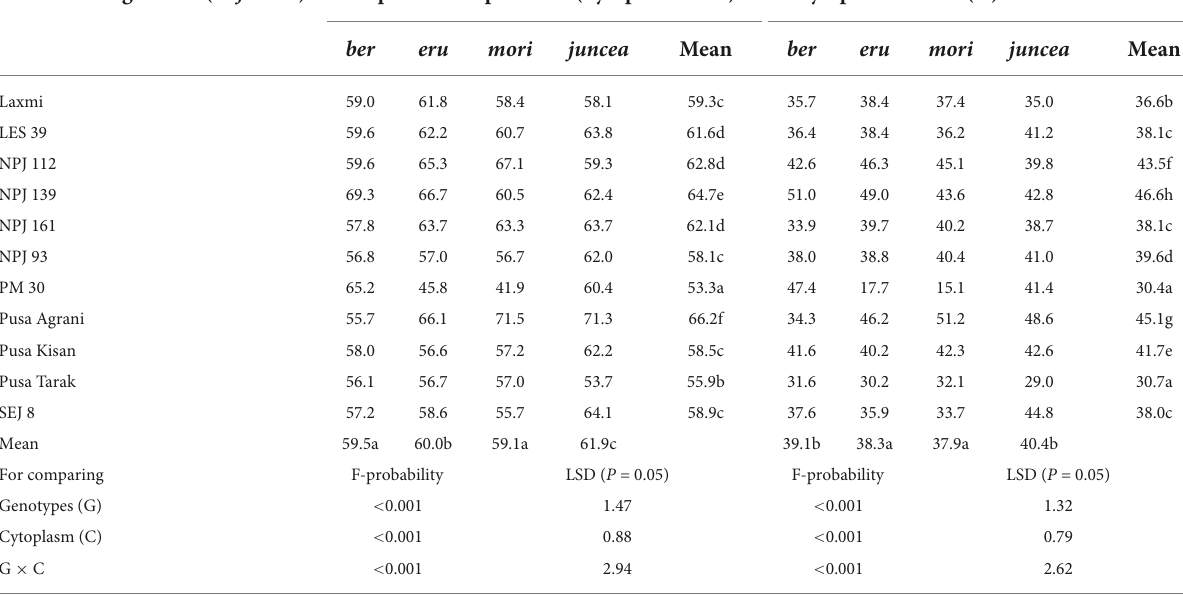
TABLE 3 Effects of cytoplasms and nuclear backgrounds on reproductive potential and survival of Lipaphis erysimi in auto- and alloplasmic lines of Brassica juncea. Nuclear backgrounds ( B. juncea ) Reproductive potential (nymphs/female)